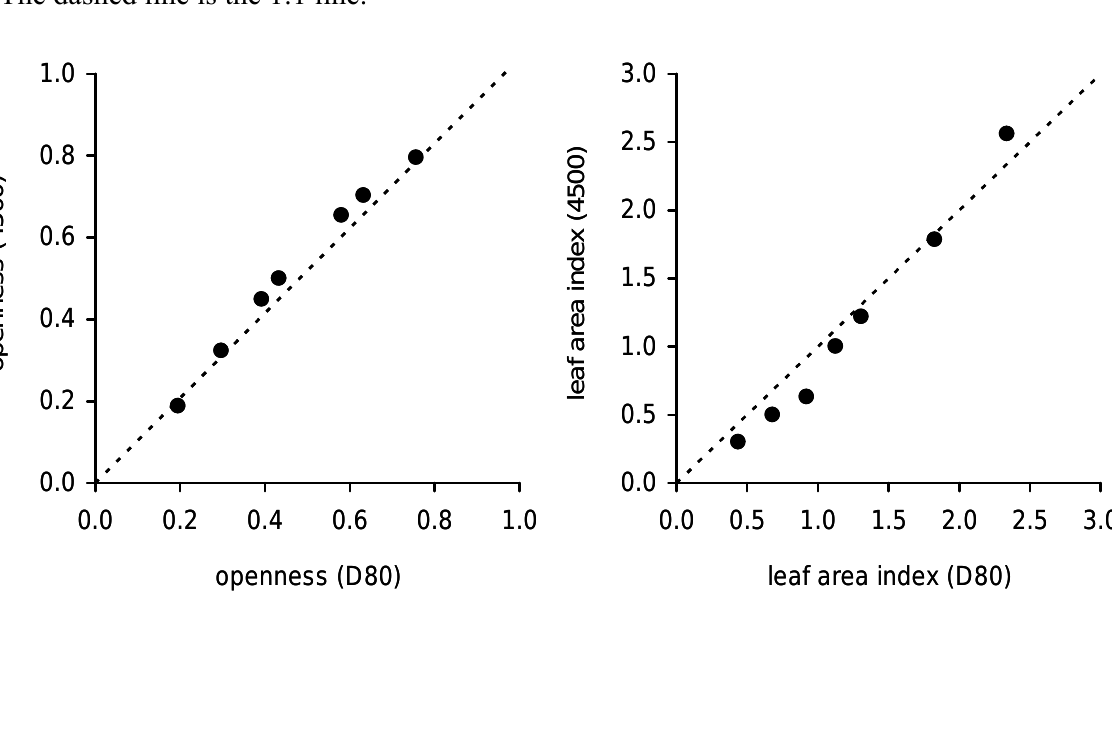
), foliage cover ( f ), c f ) for all seven forest sites 0